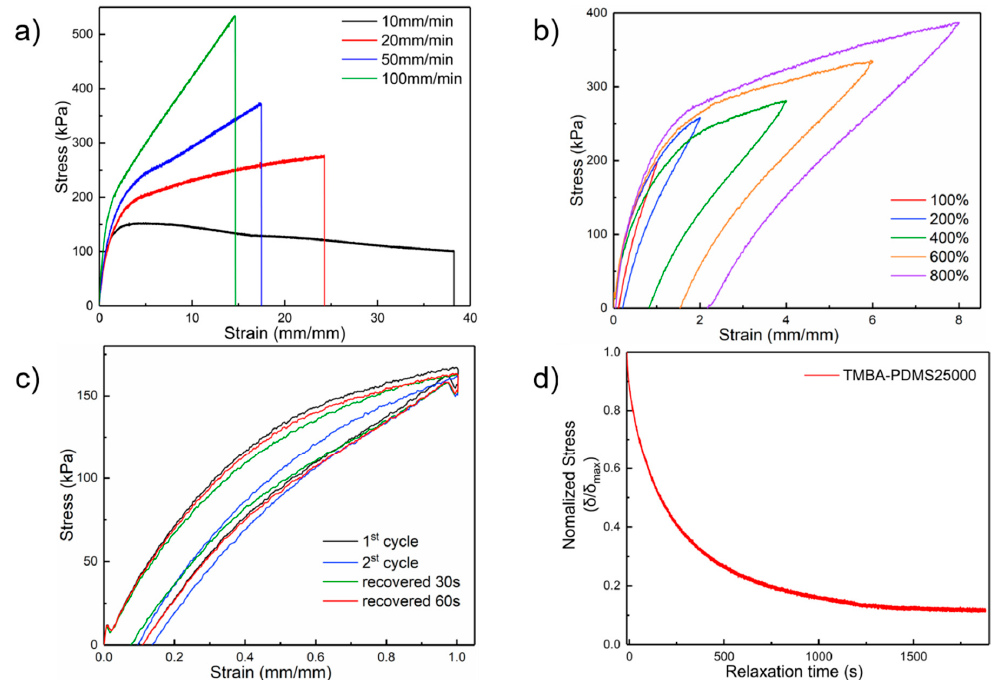
Figure 3. ( a ) Stress–strain curves of the TFPM-PDMS-25000 samples under different stretch speeds ranging from 10 to 100 mm min − 1 at 25 °C. ( b ) Cyclic stress–strain tests of TFPM-PDMS-25000 with different strains at room temperature. Strain rate = 100 mm min − 1 . ( c ) Cyclic stress–strain tests of TFPM-PDMS-25000 with different relaxation times at room temperature. Strain rate = 100 mm min − 1 .